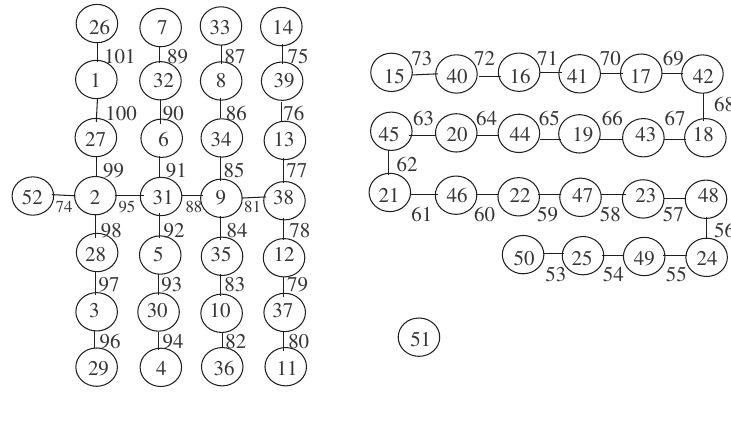
Figure 6: SEMT forest Cb 2 4,7 ∪ P 22 ∪ K